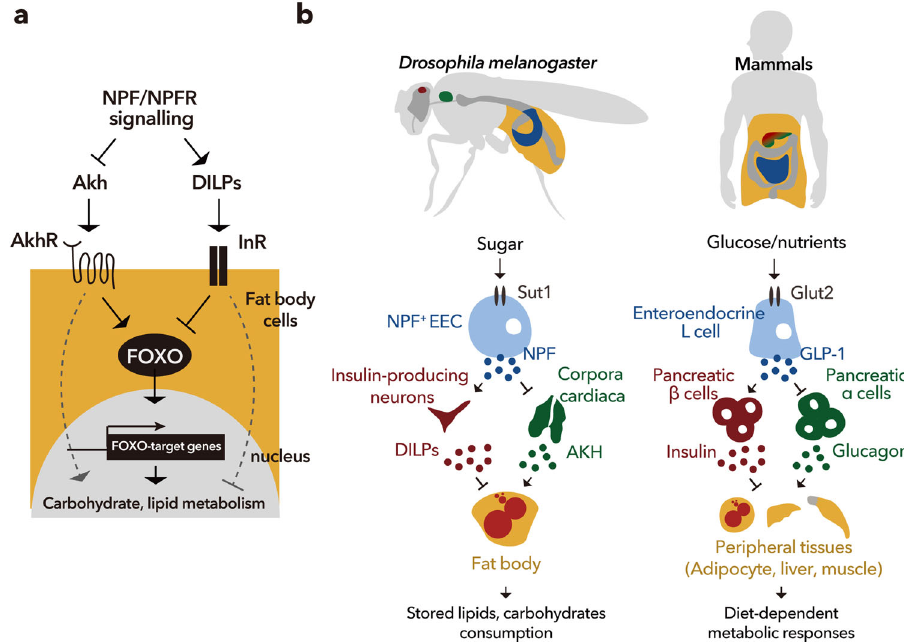
Fig. 9 Midgut-derived NPF regulates AKH and DILPs level in response to dietary sugar. a A working model illustrating dual pathway coordination of FOXO and FOXO-target genes. (i) The loss of NPF/NPFR signalling in the CC — enhanced AKH/AKHR signalling induces FOXO nuclear localisation and carbohydrate/lipid metabolism — and (ii) the loss of NPF/NPFR signalling in the IPCs — attenuation of insulin signalling induces FOXO nuclear localisation and enhances carbohydrate/lipid metabolism. The balance of AKH/AKHR and insulin signalling is coordinated by gut-derived NPF that responds dietary sugars. b (left) In D. melanogaster , enteroendocrine cells respond to the dietary sugars by secreting a neuropeptide, NPF, which signals via its neuronal receptor NPFR. NPF/NPFR signalling regulates energy consumption through dual neuronal relay which are restriction of glucagon-like, AKH production, and enhancement of insulin-like peptides (DILPs). Subsequent modulation of AKHR and insulin signalling within the fat body/adipose tissue maintains lipid/ carbohydrate catabolism; thus, impaired NPF/NPFR signalling leads to depletion of energy stores. (right) The EEC-IPC and the EEC-CC axes in D. melanogaster are similar to the gut EECs-pancreas axis in mammals. Mammalian enteroendocrine hormone, GLP-1 also controls insulin and glucagon levels in response to dietary